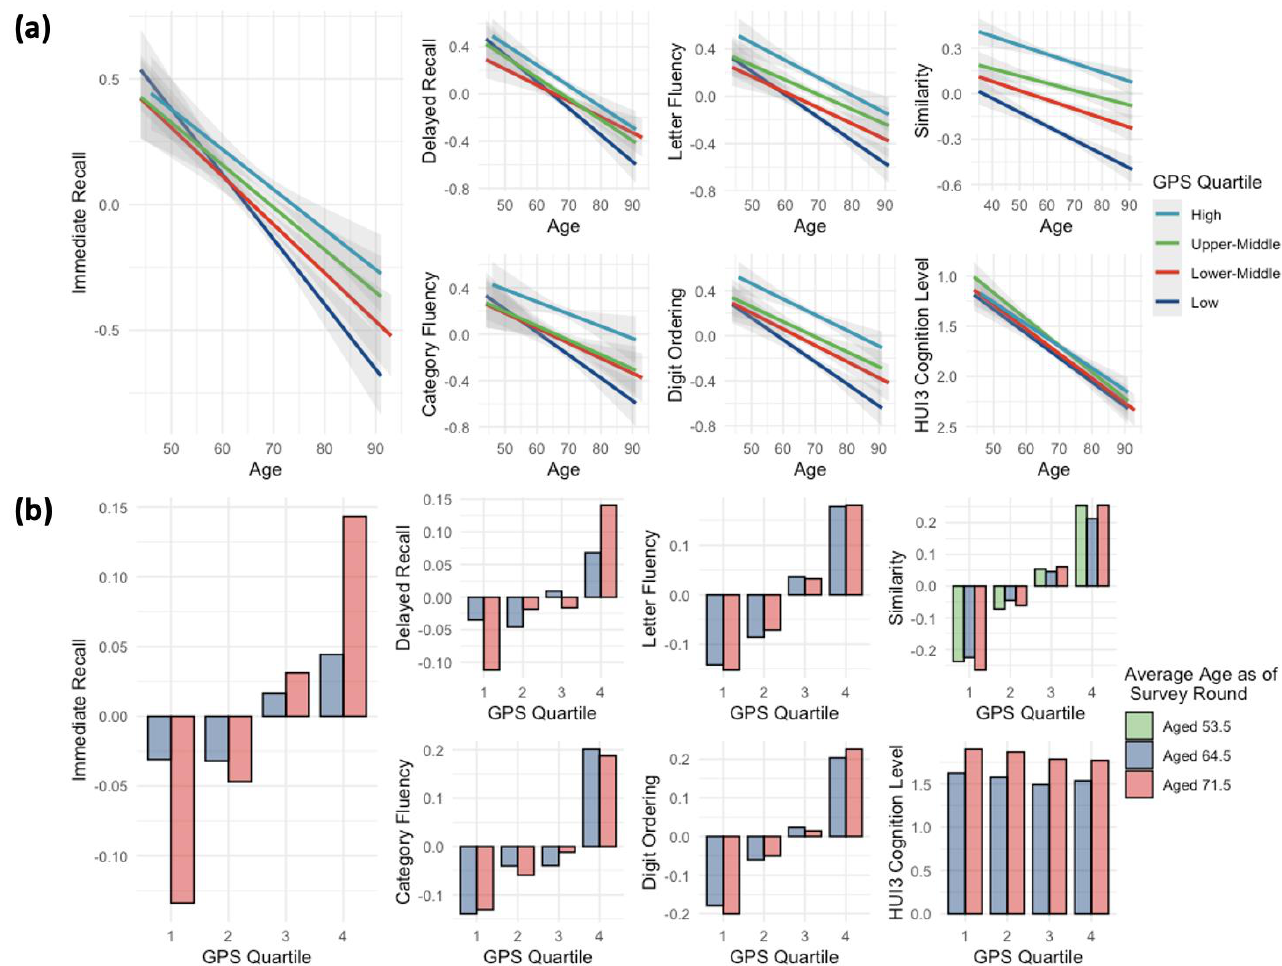
Figure 2. Graphical results of the linear mixed-effect model analysis showing that individuals with a higher cognitive GPS presented a slower trajectory of memory decline than those with a lower GPS. Changes in seven cognitive assessments (immediate recall task, category fluency task, digit ordering task, delayed recall task, letter fluency task, similarities task, and health utility index (HUI) level 3 cognition level) and the interaction effects of the CP GPS are shown. The selected seven cognitive assessments were repeatedly administered to 8511 European ancestry individuals between the average age of mid − 50s (survey timepoint 1) and mid − 70s (survey timepoint 3). ( a ) Interaction plots showing the different slopes of age − dependent interaction effects by the cognitive capacity GPS on the cognitive assessments. The x − axis indicates the age of the WLS participants at the survey timepoint, while the y-axis indicates each cognitive assessment score (z − scored). The four lines indicate the different slopes of the individuals’ cognitive changes stratified by GPS. The gray area represents the 95% confidence interval of each slope. The similarities task was the only task that was repeatedly administered to the participants since timepoint 1 (Average participants’ age 48.6). ( b ). Bar plots showing the stratification performance of the cognitive capacity GPS in each cognitive assessment module. Quartile 1 on the x-axis includes the individuals with the lowest cognitive GPS (bottom 25%) and Quartile 4 includes the individuals with the highest. The number on the y-axis represented the average phenotypic scores by each GPS quartile.